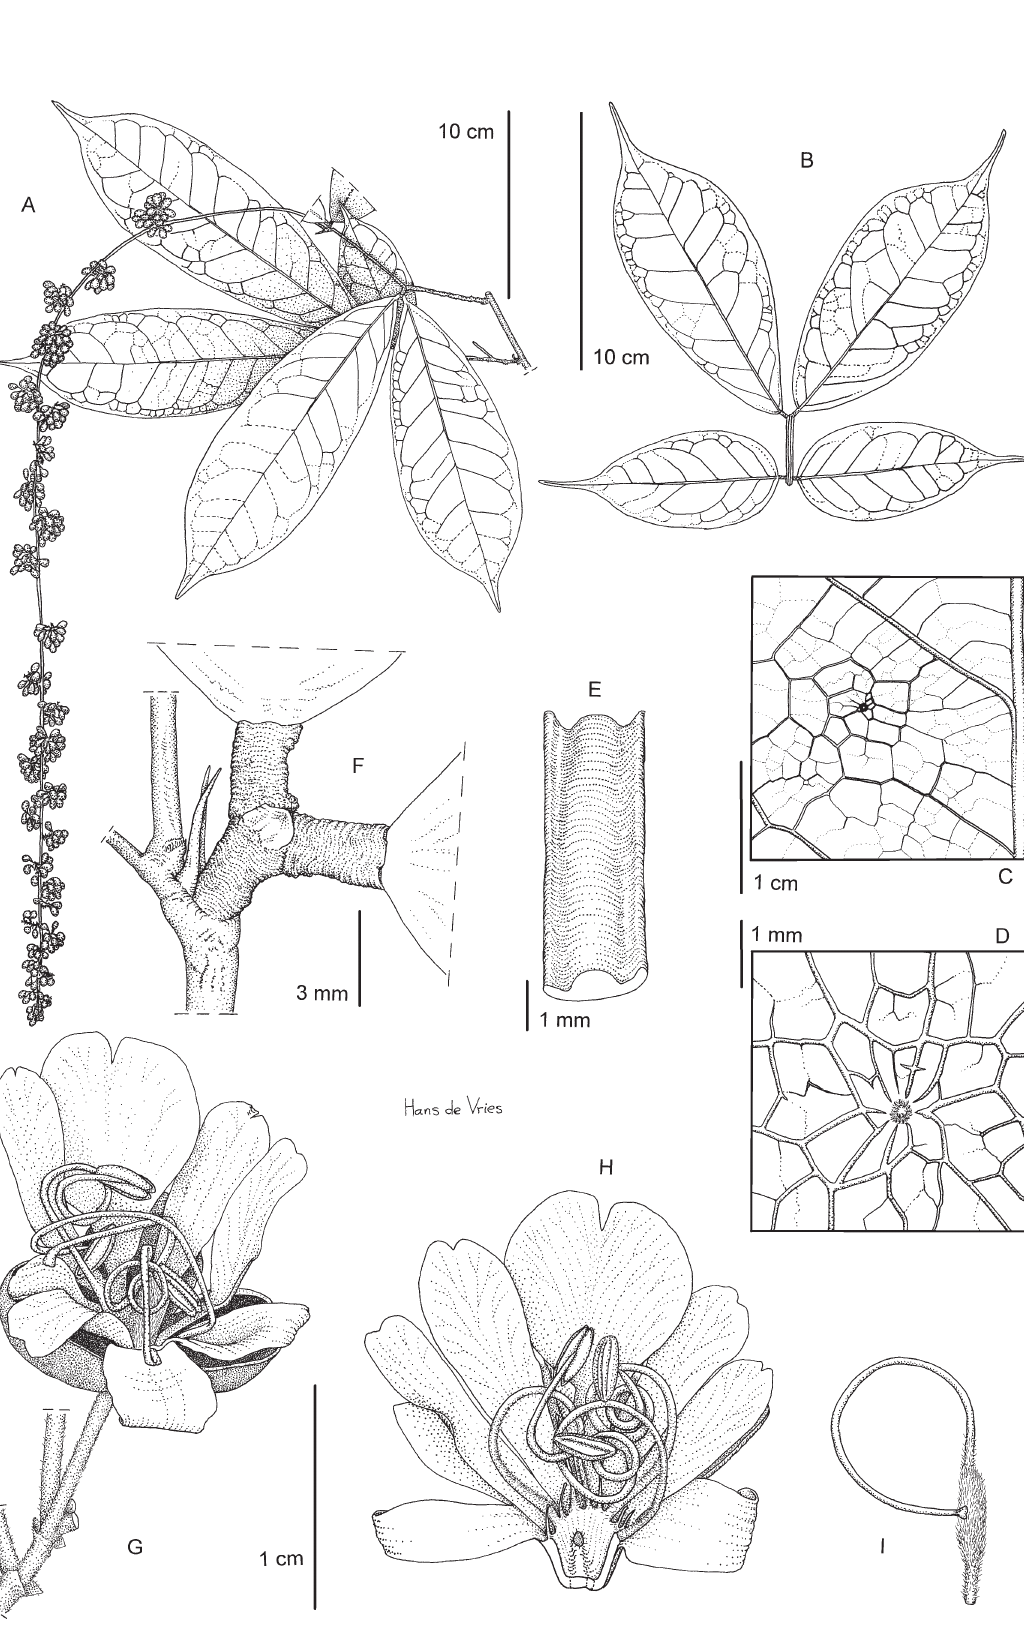
Figure 1 – Englerodendron nguemae . A . Flowering branch. B . Leaf. C . Detail of the lower leaf surface. D . Detail of a gland. E . Detail of the leaf rachis, seen from below. F . Node with stipules. G . Flower. H . Open flower, inside. I . Ovary and style. From Bidault et al. 2214 (BRLU & MO). Drawn by Hans de